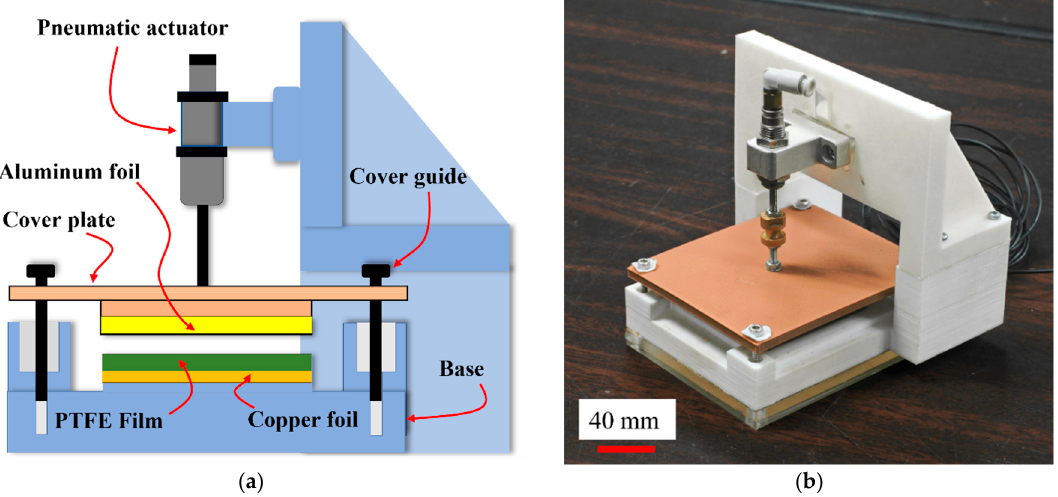
Figure 1. TEHTB structure: ( a ) essential component: cover plate, cover guide, triboelectric material (PTFE film), Aluminum foil (top electrode), and copper foil (bottom electrode); and ( b ) photograph of TEHTB.